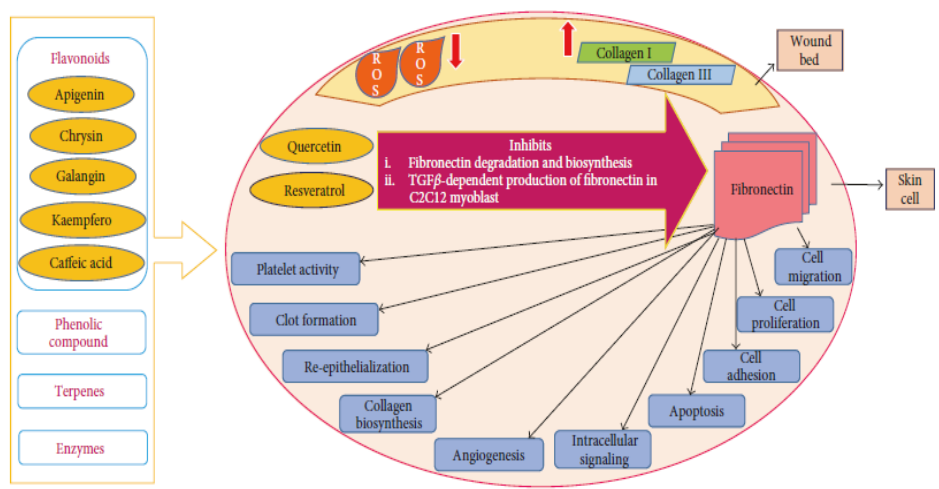
Figure 6. Molecular mechanism targeting the wound healing activity of propolis. Reprinted from [69]